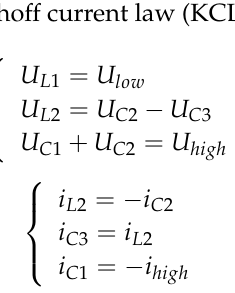
0 – t 1 ]. ( b ) [ t 1 – t 2